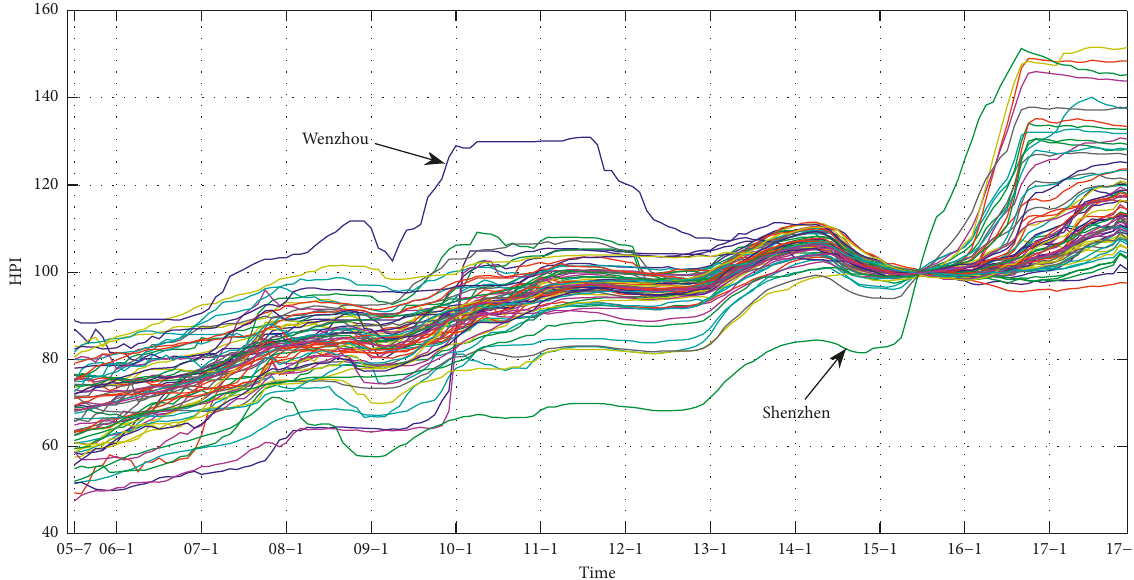
Figure 2: HPI trend of each